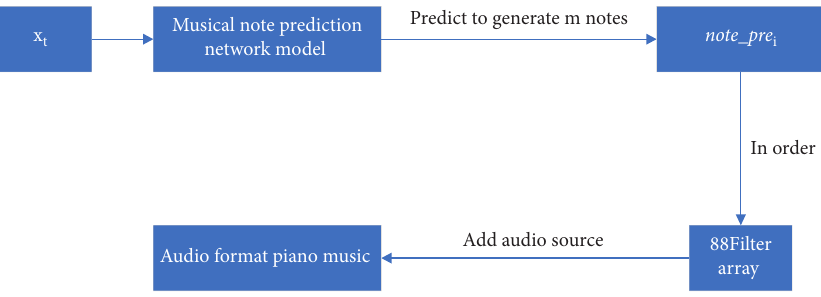
Figure 3: Automatic composition neural network model composition process. Table 1: The scoring standards.